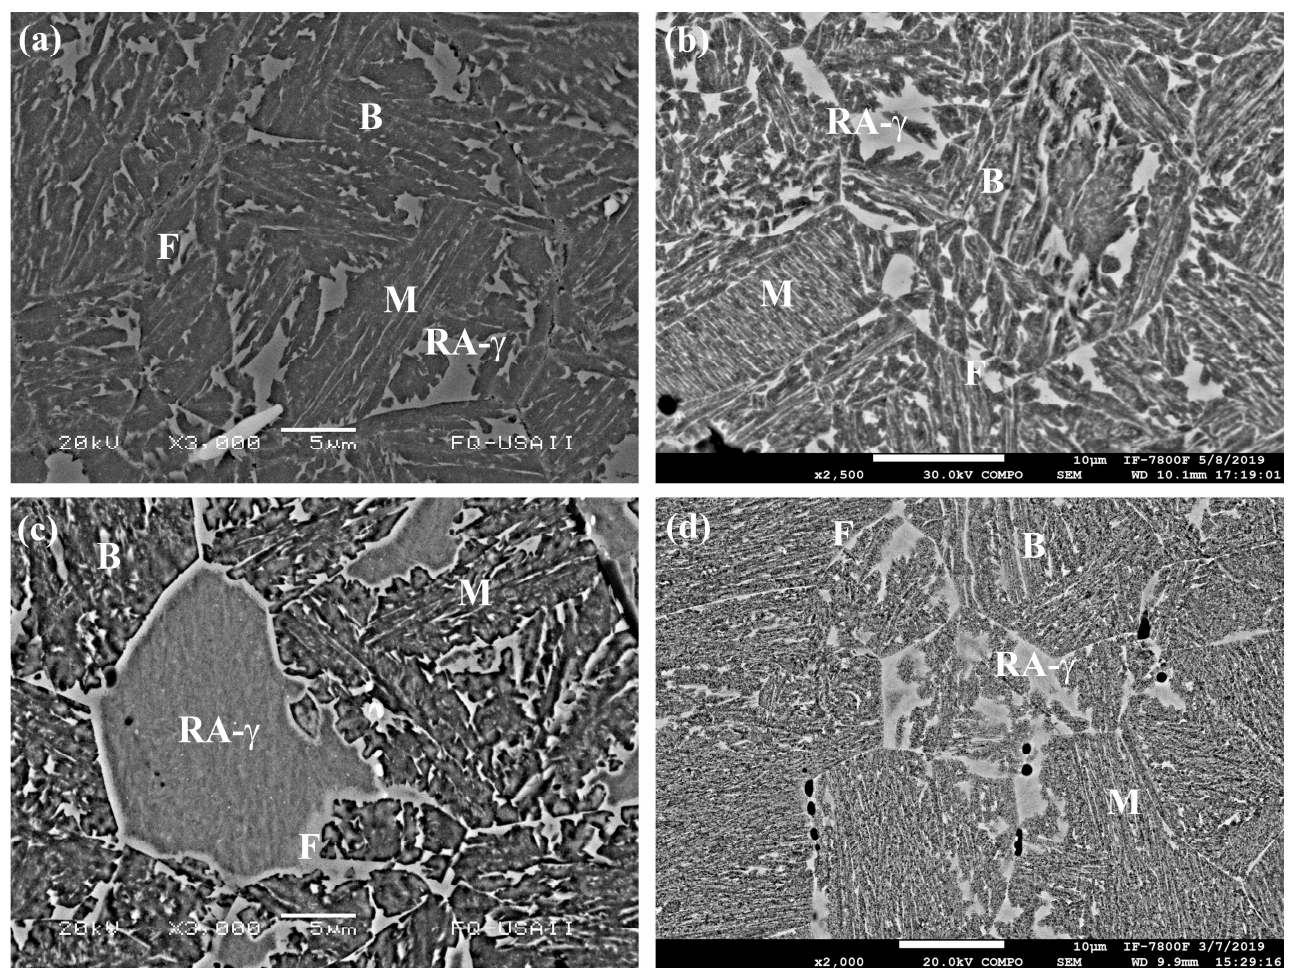
Figure 13. SEM micrographs of the microstructure of ( a , b ) boron-free steel given the Q&P treat- ment P1 and P2, respectively, and ( c , d ) boron-containing steel given the Q&P treatment P1 and P2,